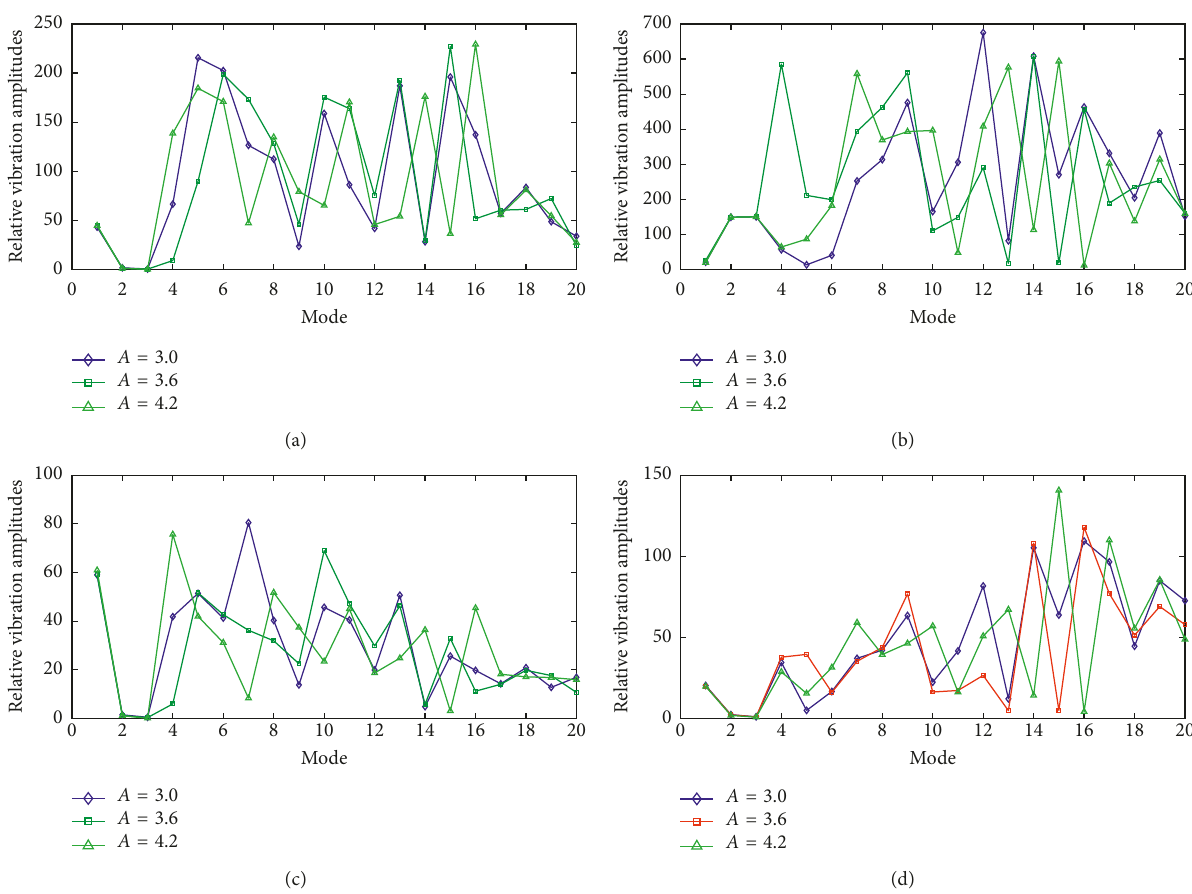
Figure 9: Vibration amplitudes for several track amplitudes. (a) First-step output shaft; (b) second-step output shaft; (c) first-step movable teeth; (d) second-step movable teeth. Table 4: Natural frequencies for several sine track amplitudes.